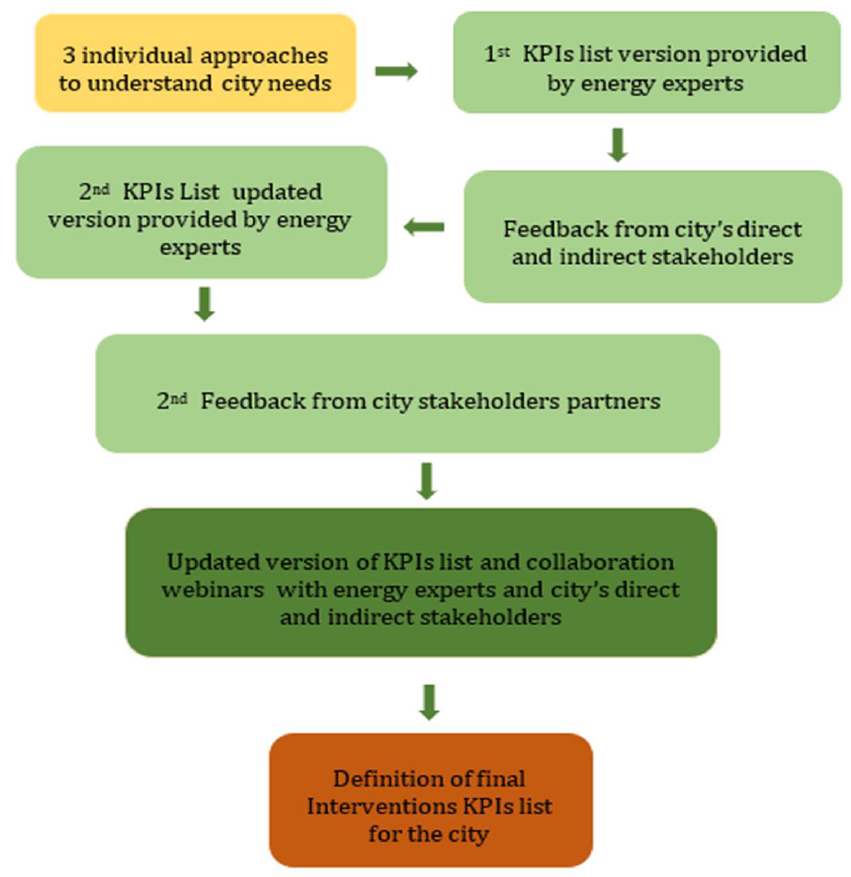
Figure 3. Collaboration among experts and city representatives .